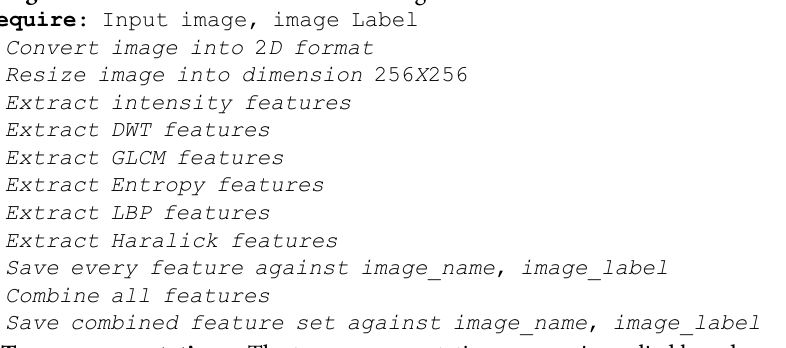
Algorithm 6 Feature extraction from image